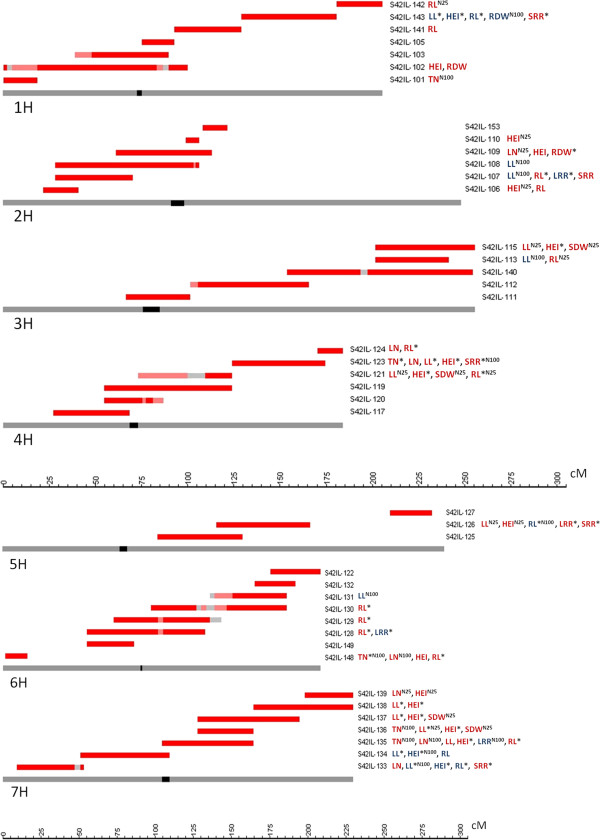
SNP map with 58 significant (P <0.01) QTL effects among 42 S42ILs and nine traits. The chromosomes 1H to 7H are indicated as grey bars. The centromeric region is indicated as a black box within the chromosome. The cM positions of the SNP loci are indicated with the ruler at the bottom, according to Schmalenbach et al.
[19]. The extent of the target Hsp introgression of each S42IL is given above the respective chromosome. Homozygous Hsp loci, heterozygous Hsp loci and loci without SNP data are presented in red, pink and light grey, respectively. The associated QTL effects are indicated right to the introgressions with abbreviations of the nine traits, i.e. TN, LN, LL, HEI, SDW, RL, RDW, LRR, SRR. Trait abbreviations are explained in Table
2. The colour of the abbreviations indicates an increasing (red) or decreasing (blue) Hsp effect. Highly significant (P < 0.001) associations are highlighted with an asterisk. Trait associations that were only detected under one treatment are labelled with N100 or N25, respectively.